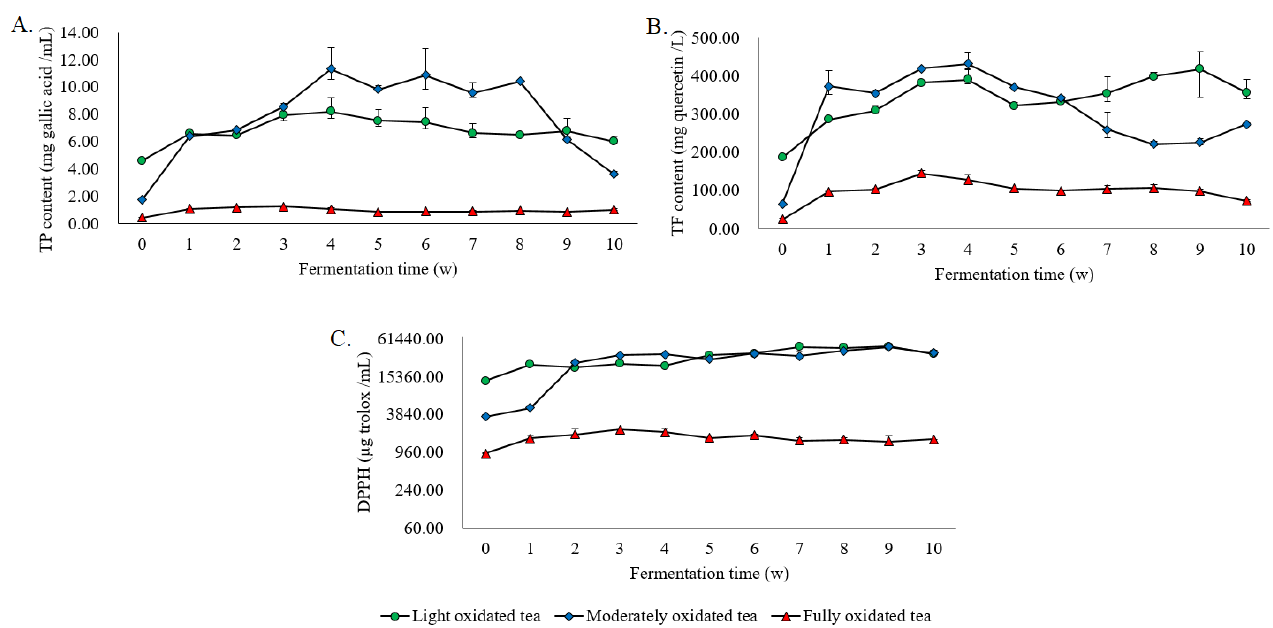
Figure 3. Changes in the antioxidant contents and capacity of three different oxidized teas during fermentation. ( A ) Total phenols (TP) content, ( B ) Total flavonoids (TF) content, ( C ) DPPH antioxidant capacity. The mean values ± standard variation of three replications indicated a significant difference at p < 0.05.